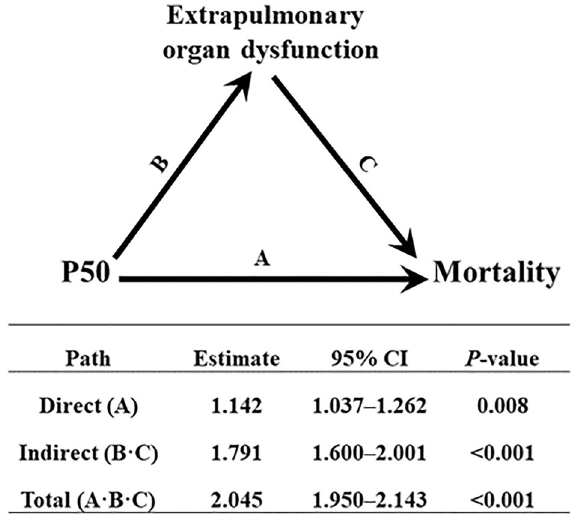
Figure 2. Analysis of the effect of P50 on mortality mediated by extrapulmonary organ dysfunction. The effect estimates on hazard ratio scale and 95% confidence intervals (CI) are tabulated for all paths: direct effect, A; indirect effect, B·C; and total effect, A·B·C. The model is adjusted for age, sex, weight, comorbidity, and initial PALICC grade. Proportion mediation is 81.5% (67.3–94.9%). PALICC; Pediatric Acute Lung Injury Consensus